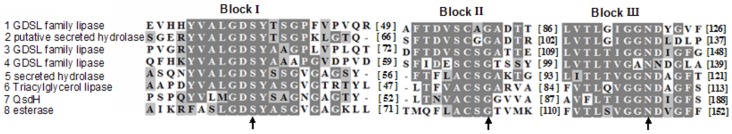
Multiple alignment of the deduced amino acid sequence of qsdH and GDSL-like lipase/esterase.1, GDSL family lipase from Amycolatopsis mediterranei U32 (GI: 300788557); 2, a putative secreted hydrolases from Streptomyces sp. Tu6071 (GI: 333028773); 3, a GDSL family lipase from Pseudonocardia sp. P1 (GI: 324999532); 4, a GDSL family lipase from Segniliparus rotundus DSM 44985(GI: 296394487); 5, a secreted hydrolases from Streptomyces sp. AA4 (GI: 302529957); 6, a triacylglycerol lipase from Kribbella flavida DSM 17836 (GI: 284031490) and 8, a esterase from Coccidioides posadasii str. Silveira (GI: 320039410). Conserved residues are shaded in gray, and the catalytic amino acid residues (Ser, Gly and Asn) in the consensus sequences are marked.